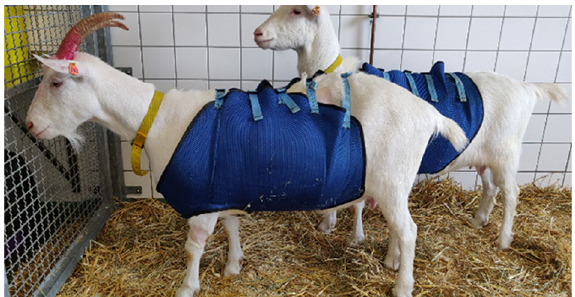
Figure 1. Experimental animal wearing a protective vest to secure the integrity of wound